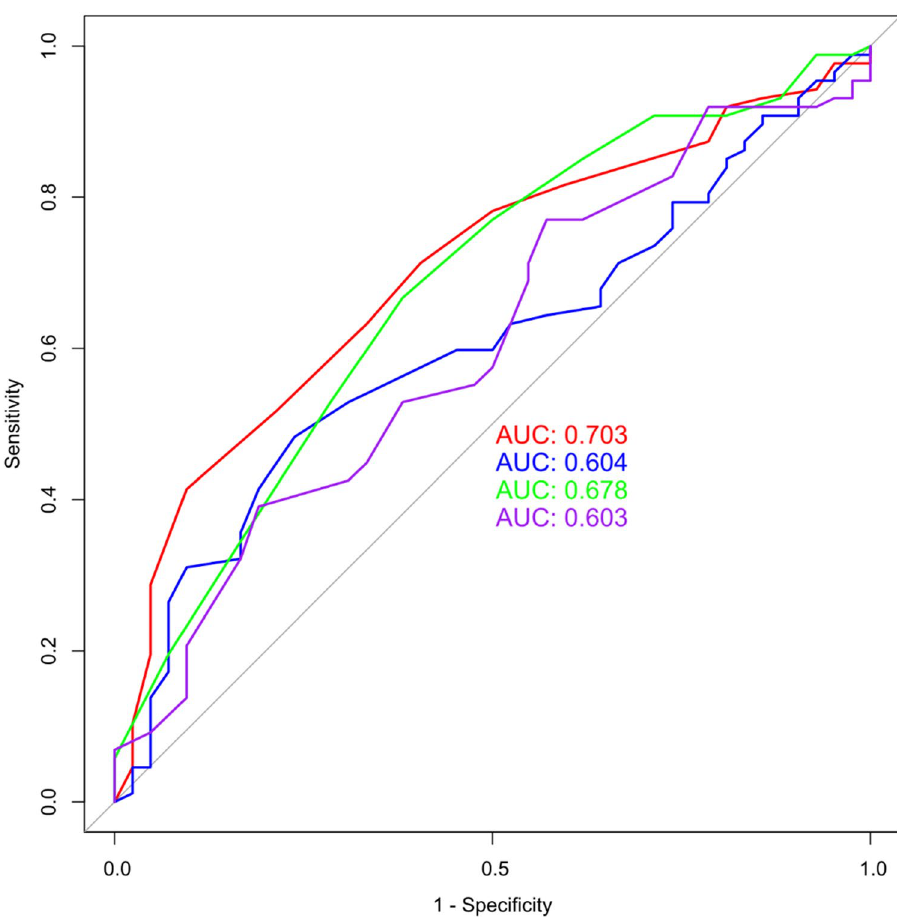
Figure 5. ROC curve of MOCA’s prediction model. (red: the optimal combination of variables; blue: the top ten features of RDA; green: the top ten features of MMSE RF analysis; purple: the top ten features of MoCA RF analysis).